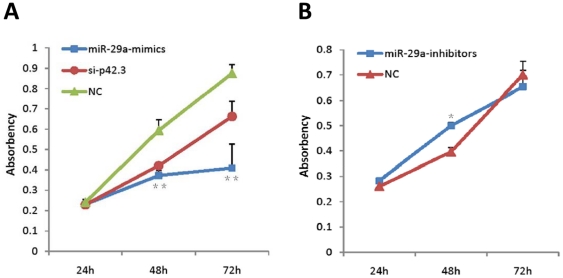
Effect of miR-29a on cell proliferation in the MKN-45 cell line.
A. MiR-29a mimics inhibited cell proliferation and the inhibiting rate at 48 h was approximately 20% and approximately 40% at 72 h, while p42.3 siRNA inhibited cell proliferation by approximately 15% at 48 h and 72 h. **: P<0.01. B. MiR-29a inhibitors promoted cell growth by approximately 10% at 48 h, but the effect weakened at 72 h. *: P<0.05.